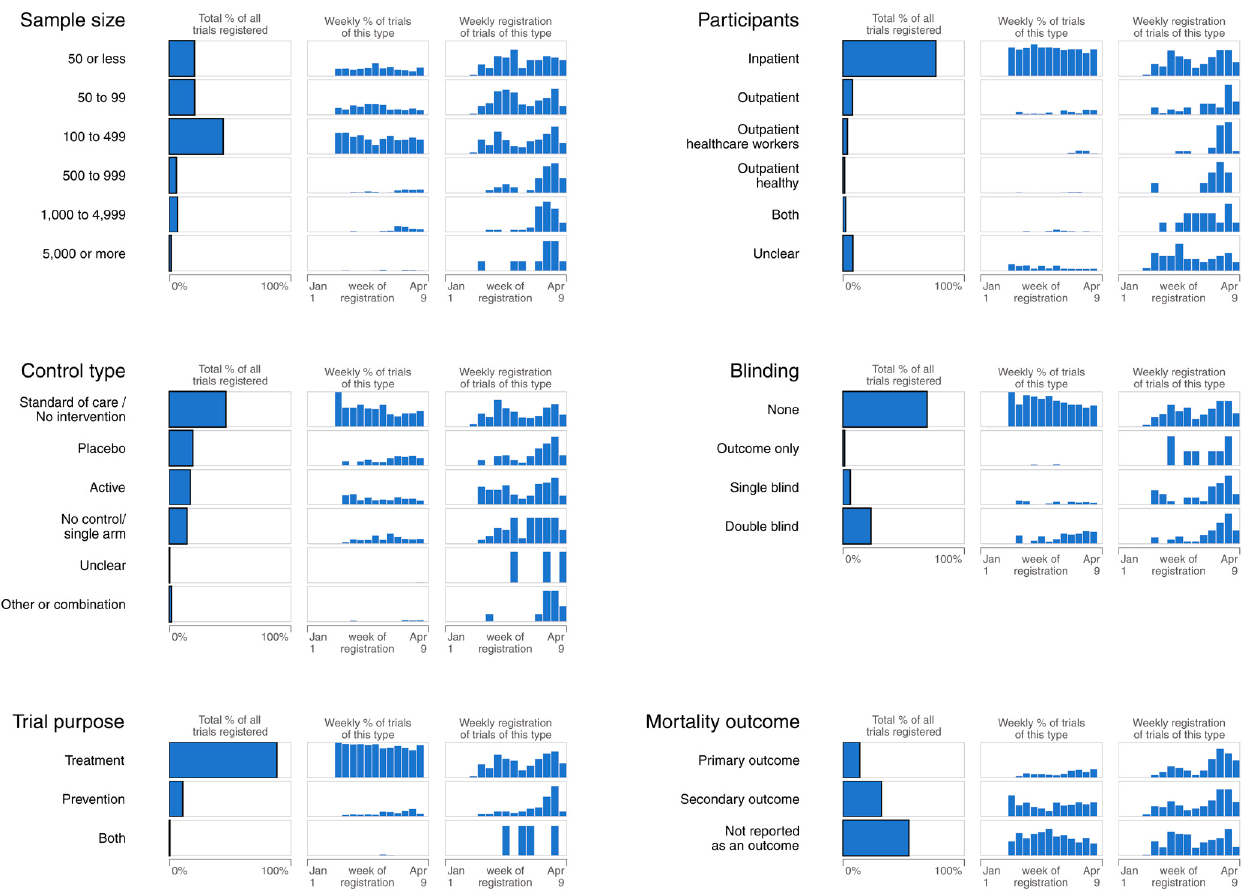
Figure 3. Proportion of trials stratified according to ( a ) sample size, ( b ) type of participants, ( c ) type of control, ( d ) type of blinding, ( e ) purpose of the trial, and ( f ) use of mortality as outcome. The first column represents the proportion of all trials that were of the specified type. The second column represents the proportion of all trials registered that week that were of the specified type (i.e. within week, between trial types). The third column represents the distribution of when trials of this type were registered (i.e. within trial type, between week), and can be interpreted as either a percentage or count (not